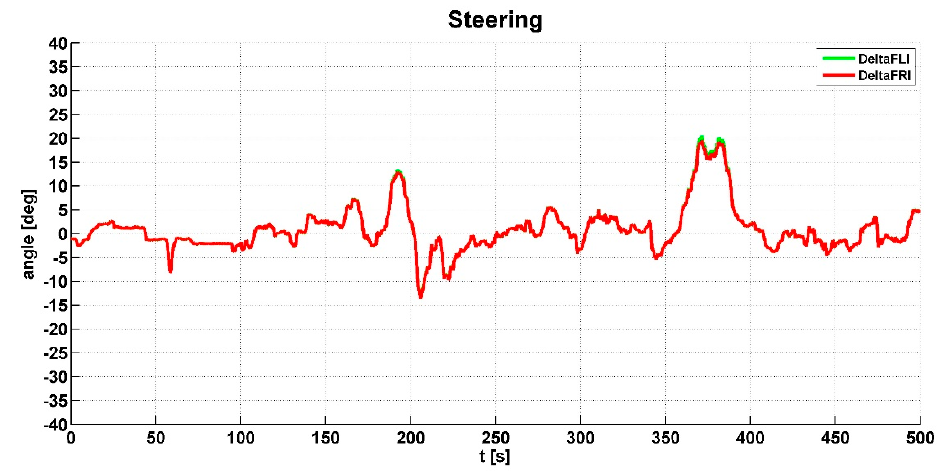
Figure 11. Values of the steering angle.